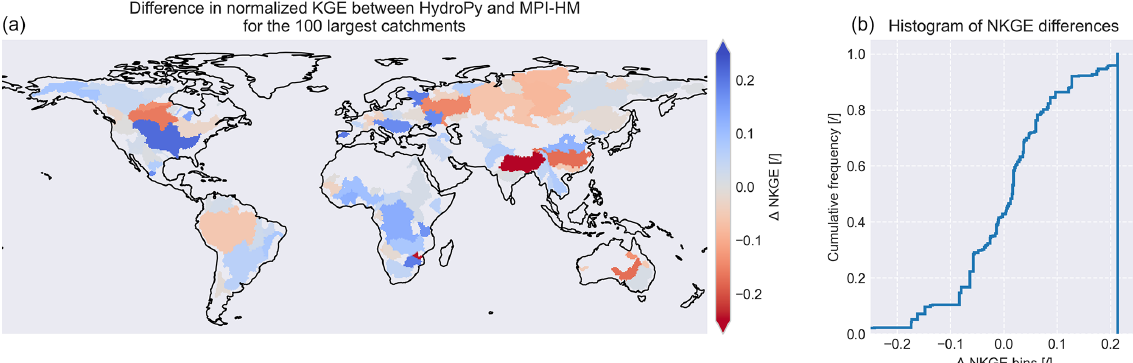
Figure 12. Spatial distribution (a) and cumulative histogram (b) of NKGE differences for river discharge between HydroPy and MPI-HM.